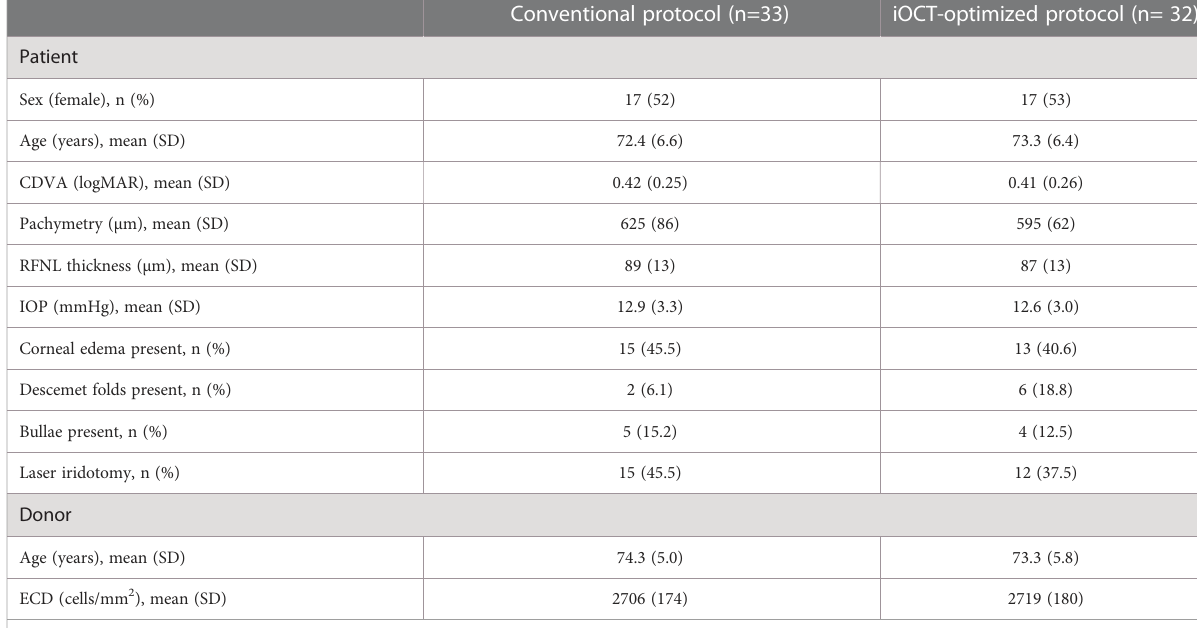
TABLE 1 Baseline patient and donor characteristics.